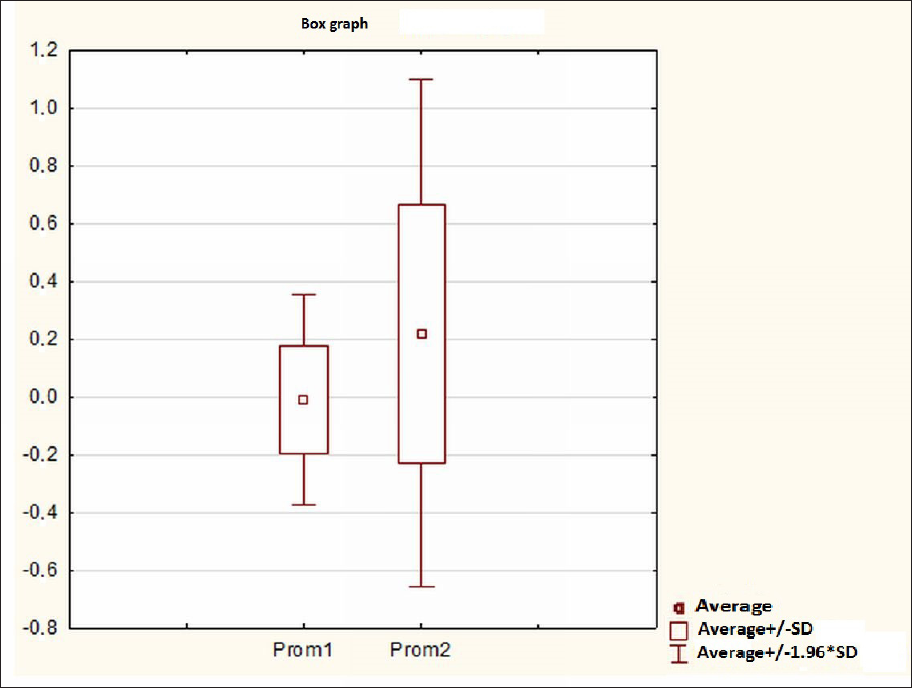
Fig. 5. Statistically significant difference between sVEP (Prom1, logMAR) and Snellen (Prom2, logMAR) method (Wilcoxon test, P = 0.02) in sample